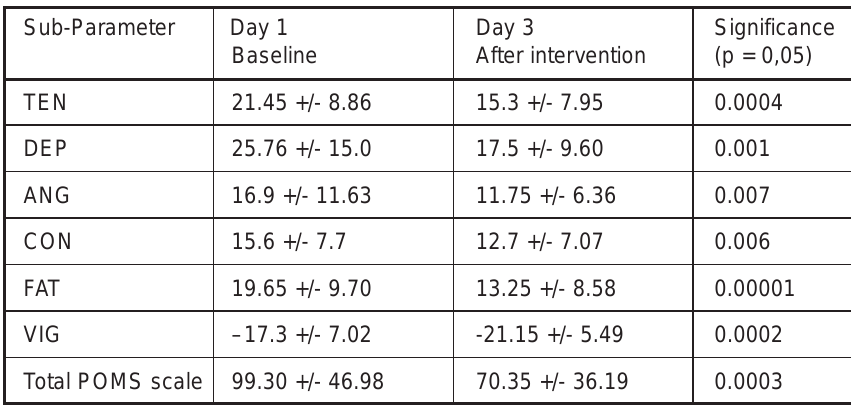
Table 3: Changes in various sub-parameters of the POMS scale in the expe- rimental group over a period of 3 days (baseline versus day 3).